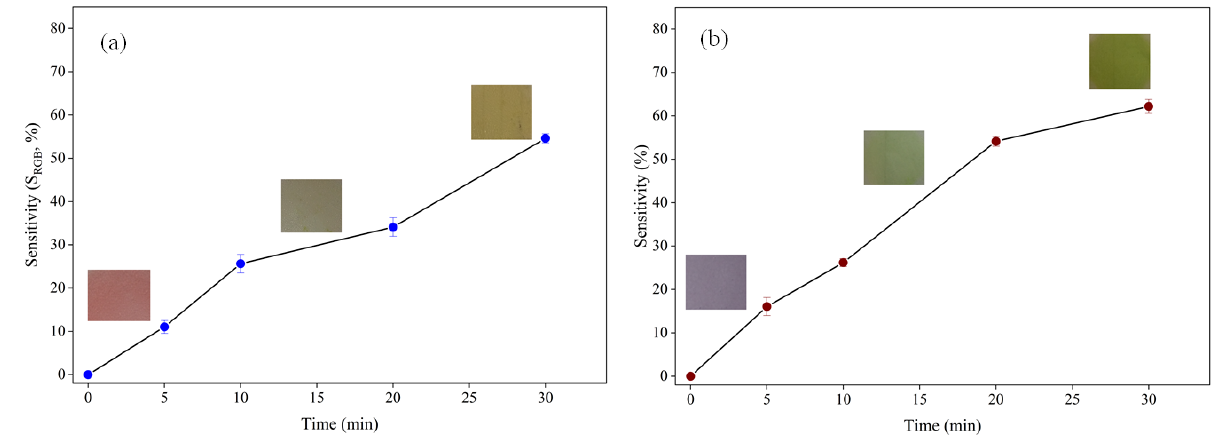
Figure 3. Ammonia-sensitivity assay of smart colorimetric indicators. ( a ) G/CsNFs/BAs; ( b ) G/CsNFs/SPAs.